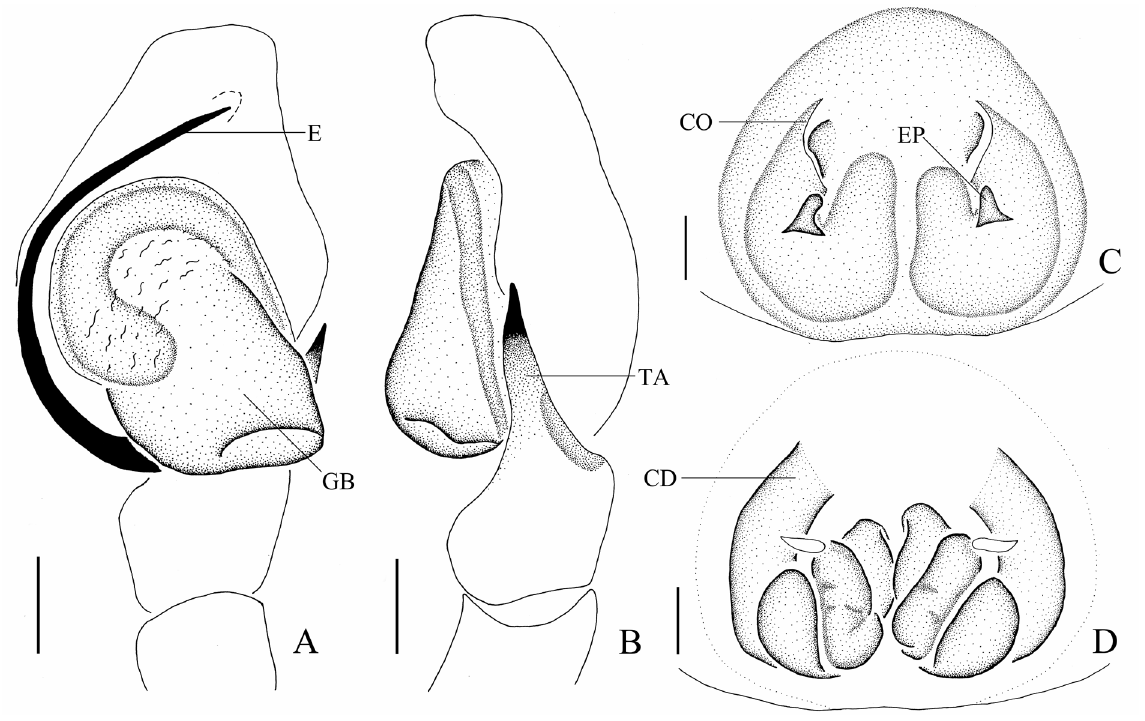
Fig. 5. Yaginumaella hubeiensis sp. nov. A – B . ♂, HNU-HB-IV-1626. C – D . ♀, HNU-HB-IV-1624. A . Male palp, ventral view. B . Male palp, retrolateral view. C . Epigyne, ventral view. D . Vulva, dorsal view. Scale bars: 0.2